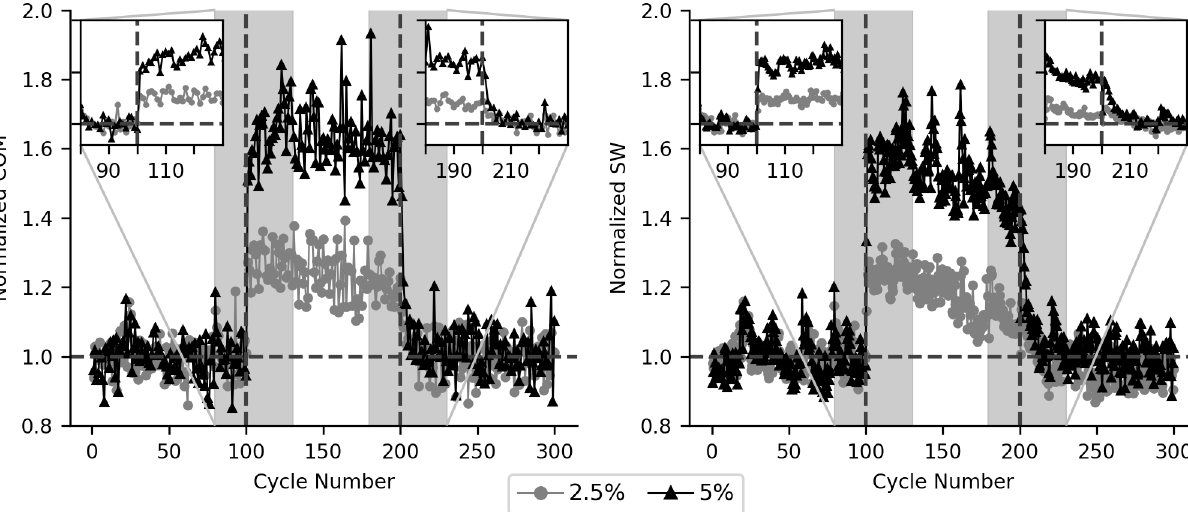
Fig 6. Time course of locomotor changes to destabilizing forces. Ensemble averaged group response to destabilizing force field without the handrail hold. Catch trials were removed and values were normalized to each participant’s average response in pre perturbation block prior to ensemble averaging. Perturbations were applied during cycles 101 to 200. Inset graphs display response at transition points of perturbation (shaded regions). COM sway and step width quickly increased when perturbations were applied, and quickly returned to baseline levels when perturbations were removed.